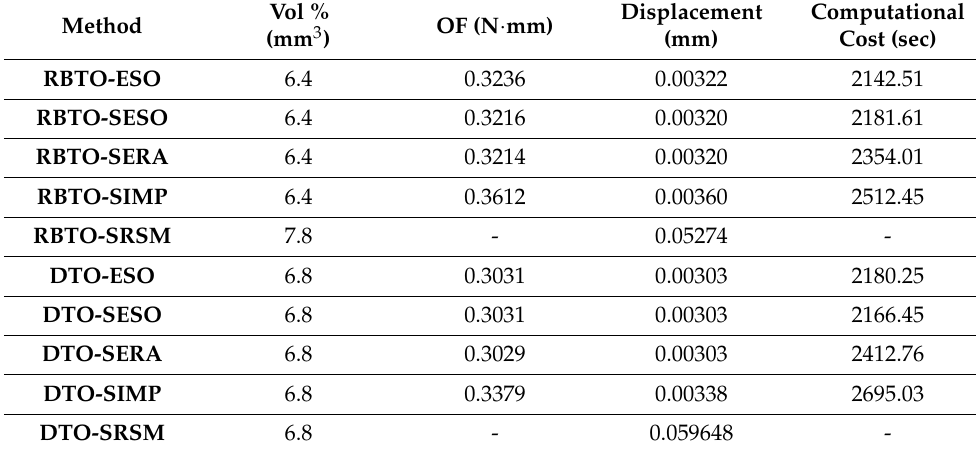
Figure 6. RBTO: contour, topology and surface: ( a ) ESO, ( b ) SERA, ( c ) SESO and ( d ) SIMP. For the 3D results’ comparison, the volumes, displacements, OF, and computation time due to each method, for the cantilever, are listed in Table 1. From the comparison of the RBTO with the DTO of the 3D cantilever beam, note that the optimal RBTO volume is about 15.38% smaller than the SRSM method proposed by [24]. Table 1. Reliability-based topology optimization using evolutionary